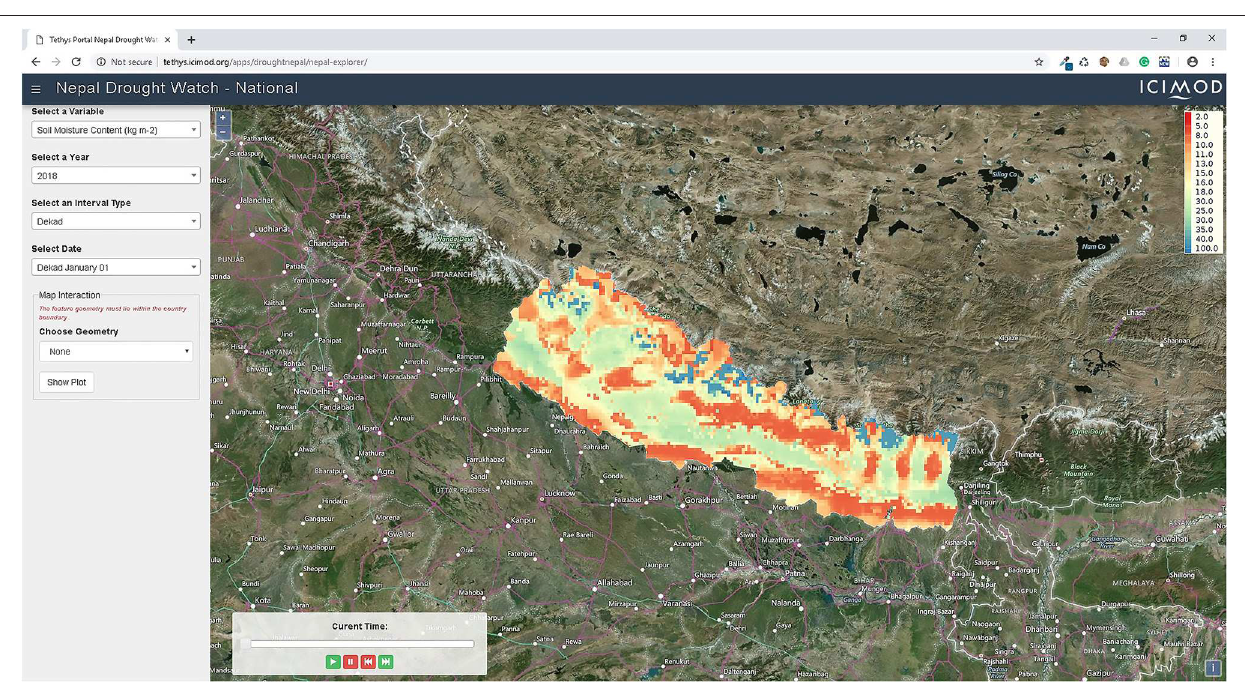
throughout the region. These drought indicators can be accessed as maps and timeseries products via two different Tethys apps that have been created. The national drought